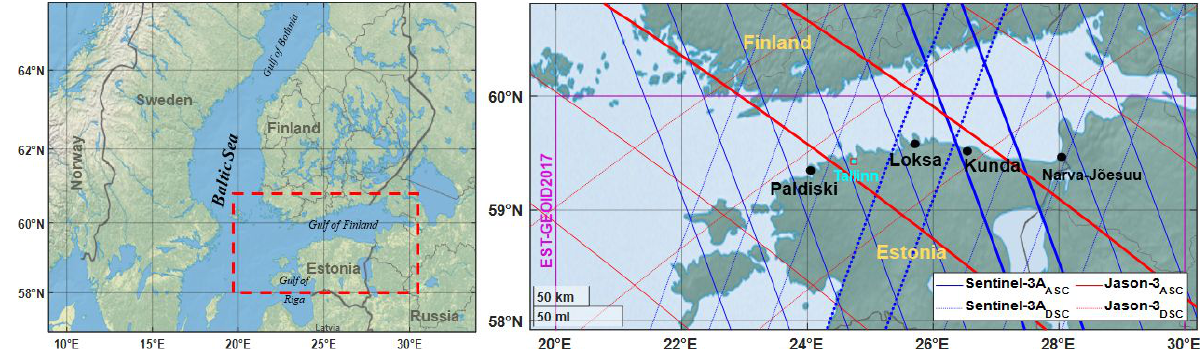
Figure 2: Location of the study area in Baltic Sea (left) and the JA3 (red) and S3A (blue) satellite tracks (used tracks are in bold) and location of tide gauge stations (black dots) in Gulf of Finland (right). Table 1: List of TG used stations and nearby SA tracks, see Fig. 2 for their exact locations.